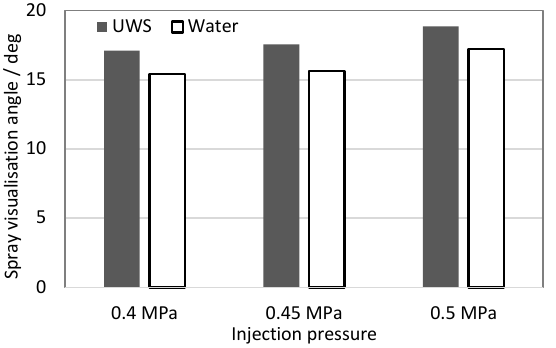
Figure 5. Spray visualisation angle.